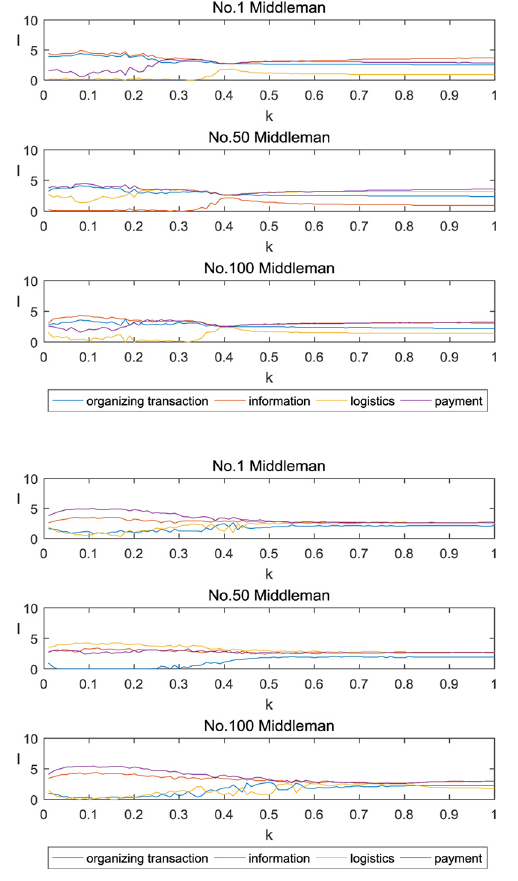
equilibrium price e =